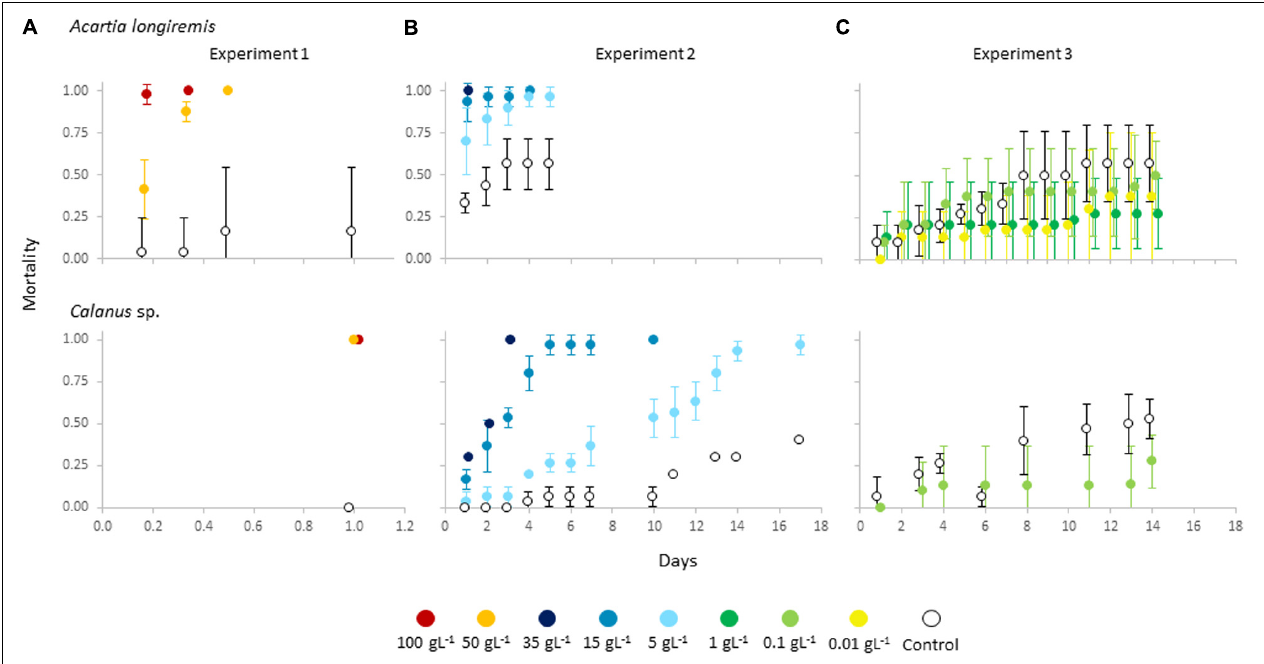
FIGURE 4 | Mortality of Acartia longiremis (upper panels) and Calanus sp. (lower panels) exposed to a range of TOS CRG leachate concentrations in three experiments; (A) Experiment 1 (50 and 100 g L − 1 ), (B) Experiment 2 (35, 15 and 5 g L − 1 ), (C) Experiment 3 (1, 0.1 and 0.01 g L − 1 ). Experiments 1, 2, and 3 ran for 1, 17, and 14 days,